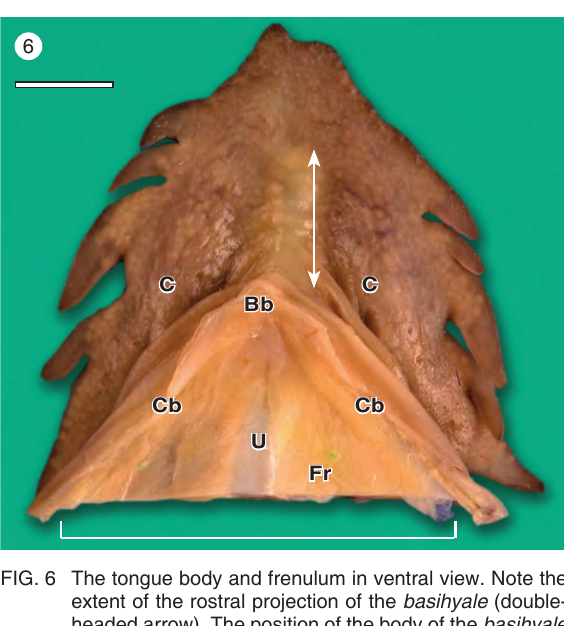
FIG. 6 The tongue body and frenulum in ventral view. Note the extent of the rostral projection of the basihyale (double­ headed arrow). The position of the body of the basihyale (Bb), rostral parts of the paired ceratobranchiale (Cb) and the urohyale (U) are indicated and occur in triangular formation running within the frenulum (Fr). The dough­ nut­shaped structures can be clearly seen below the sur­ face. Crura (C). Bar = 5 mm